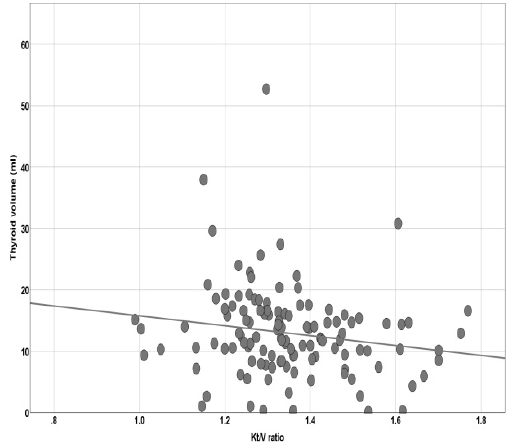
Figure 2. Pearson’s correlation between thyroid volume and Kt / v ratio.